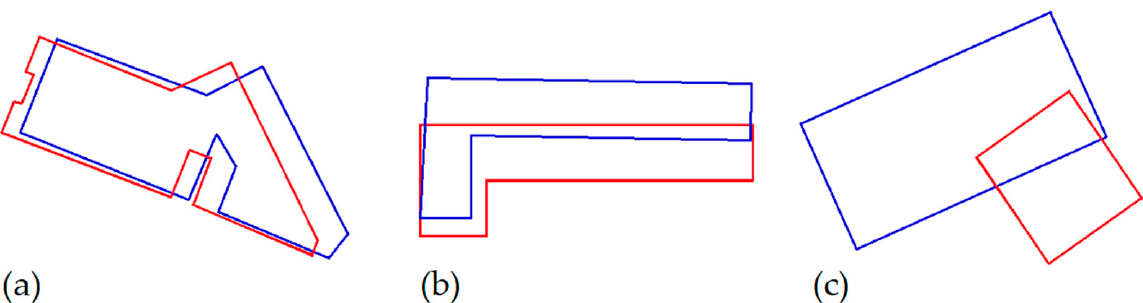
Figure 5. Degree of similarity between each pair of polygons previously matched. Examples belonging to our matching guide. Polygons from the BCN25 are represented by blue contours, while polygons from the MTA10 are represented by red contours. ( a ) High level of similarity; ( b ) middle level of similarity; and ( c ) Low level of similarity.